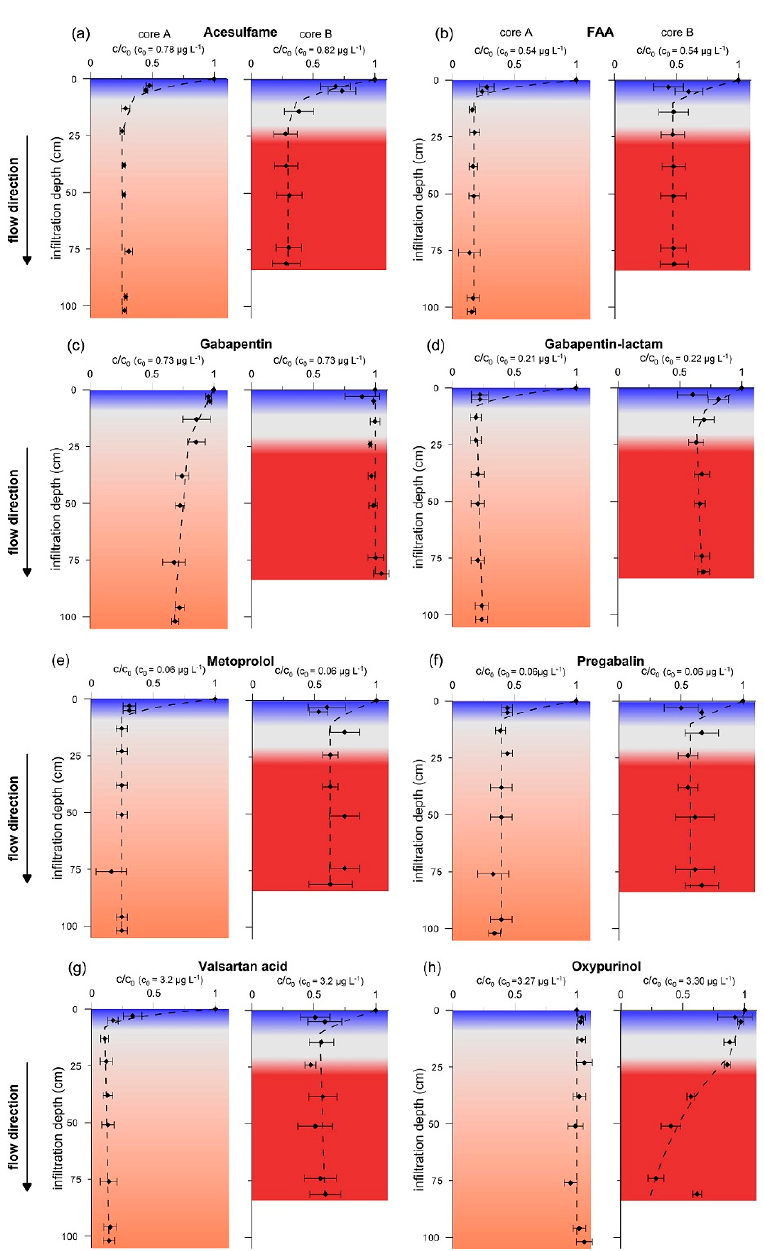
Figure 3. Concentration depth profiles (core A to the left, core B to the right) observed for ( a ) acesulfame, ( b ) FAA, ( c ) gabapentin, ( d ) gabapentin-lactam, ( e ) metoprolol, ( f ) pregabalin, ( g ) valsartan acid, and ( h ) oxypurinol. Black circles indicate arithmetic mean values of measured concentrations (n = 3) and standard deviations are given by error bars. Removal curves (dashed lines) were created assuming 1st order degradation. The colored background indicates the redox conditions prevalent in the respective part of the column as presented in Figure 2 (blue = oxic, grey = suboxic, orange/red = anoxic). The concentrations are presented here as c/c 0 , i.e., normalized to the inlet concentration c 0 (shown in brackets).